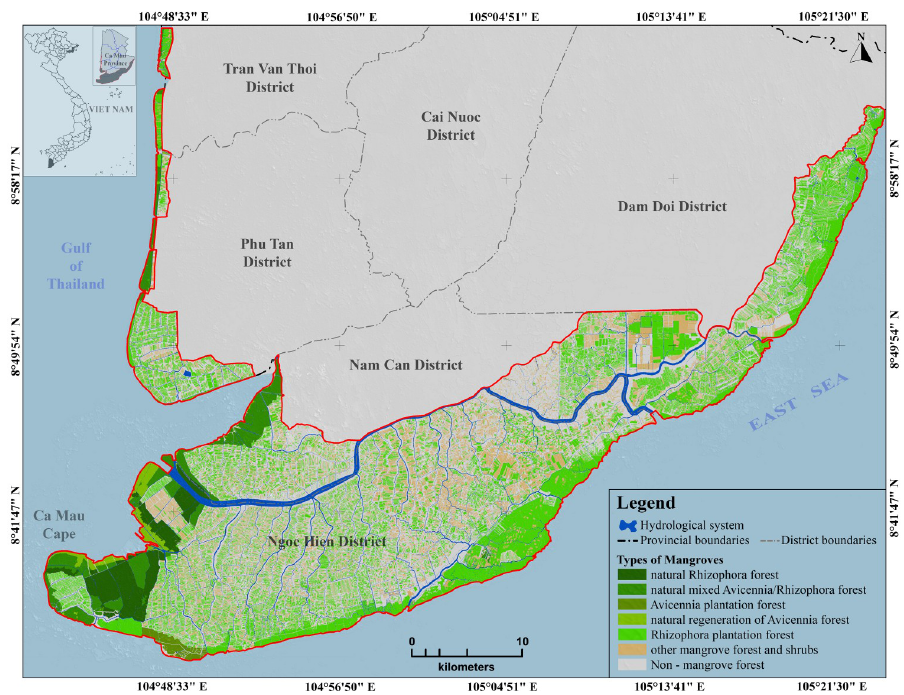
Fig 4. Mangrove forest classification with the use of the ASO-ANFIS. Background data were collected from https:// gadm.org/ and processed by the authors.